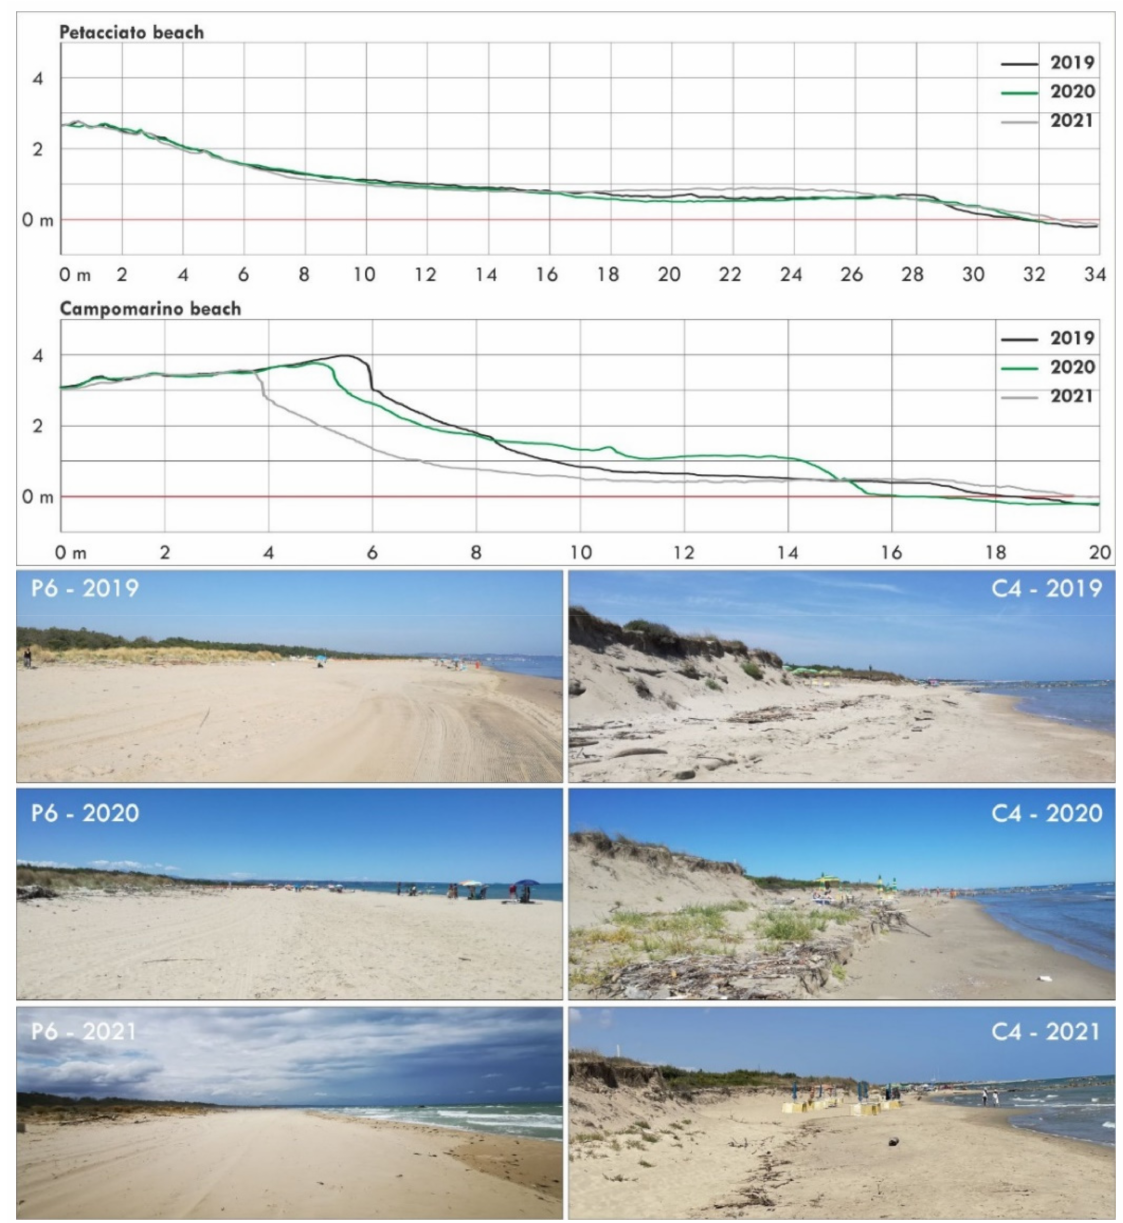
Figure 9. Representative beach profiles (C4 and P6) and panoramic views of test areas A and